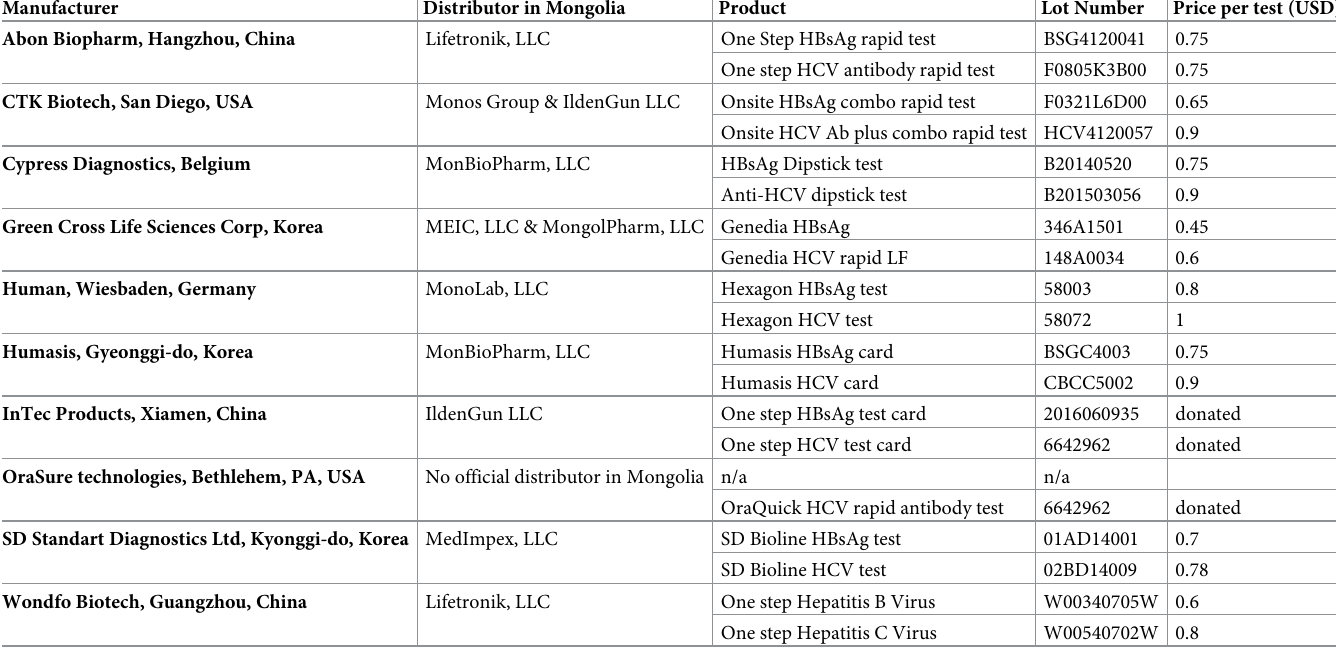
Table 1. Overview of tests kits and manufacturer. Prices are given as payed when purchased in 2015 in small quantities by local distributors in Mongolia. All manufac- turers, except OraSure, offer RDTs for HBsAg and for